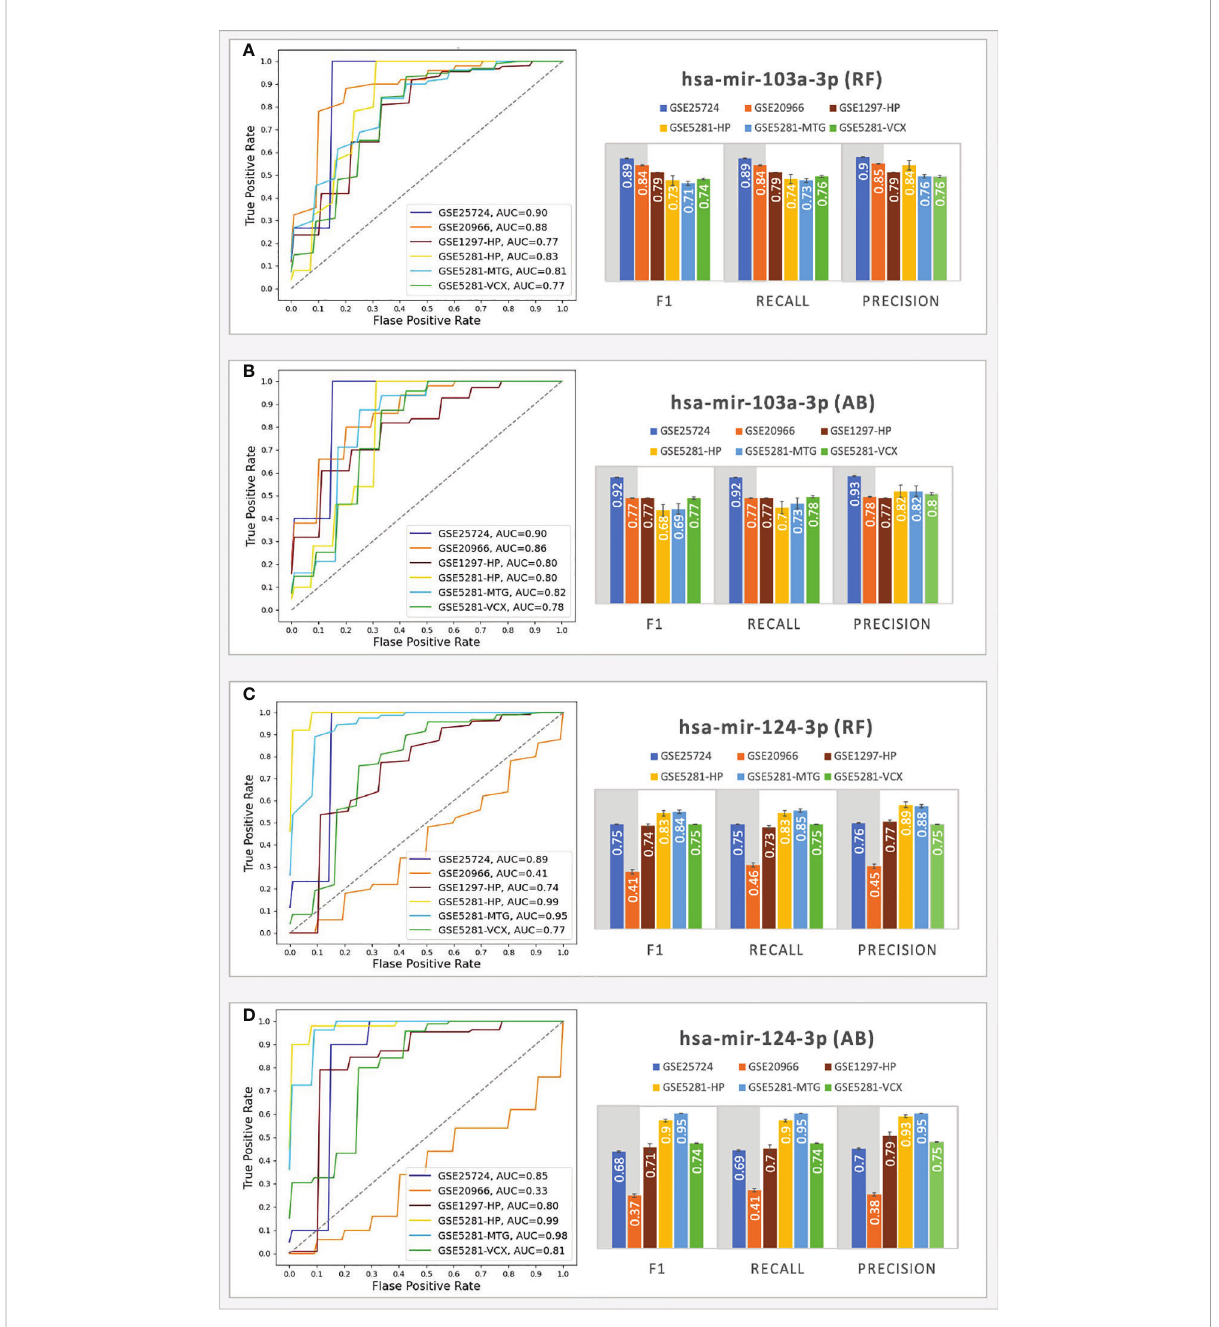
FIGURE 5 Prediction performances of the ML models (RF, AB) using the genes targeted by hsa-mir-103a-3p (A, B) and hsa-mir-124-3p (C, D) . The columns in the grey shaded area indicate T2D datasets, while the rest are